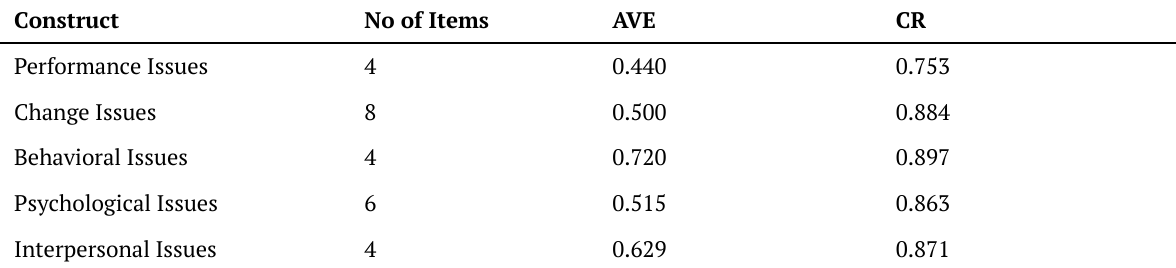
Table 2. Average variance Extracted and Construct Reliability of